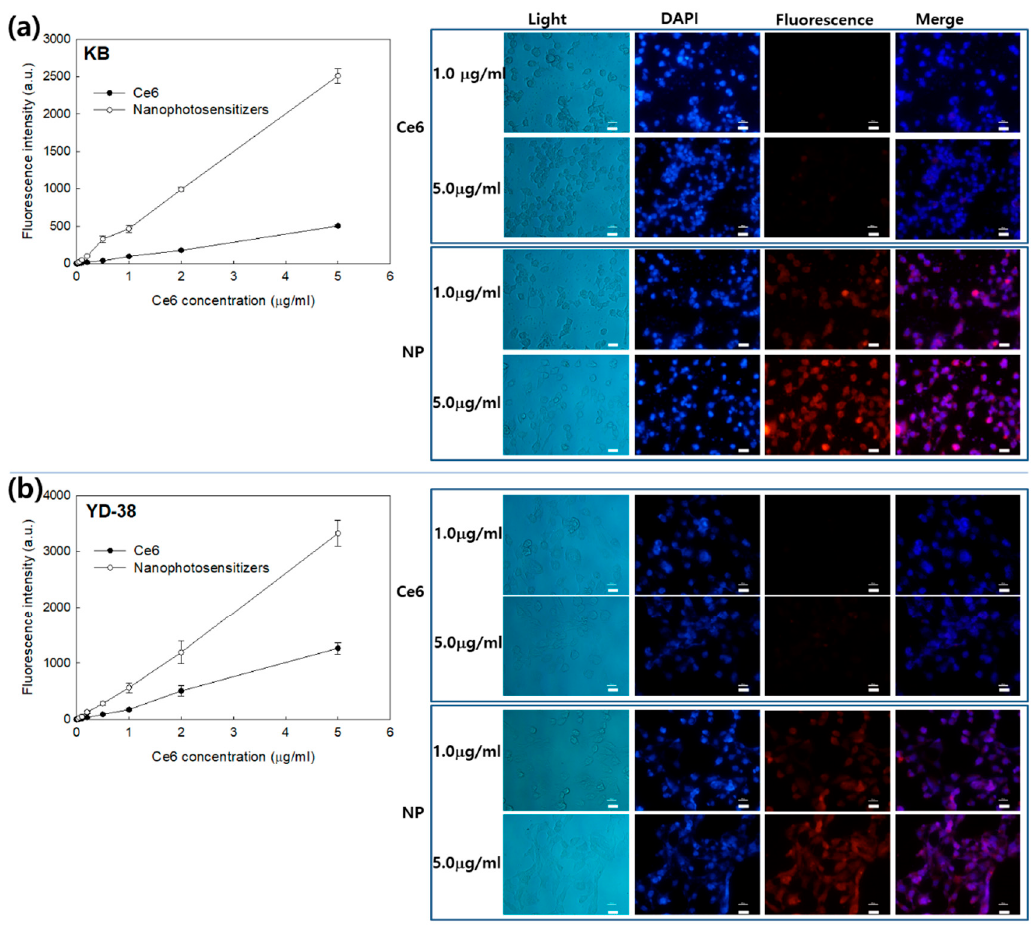
Figure 4. Ce6 uptake ratio (left panel) and fluorescence microscopic observation (right panel) of Ce6 alone and FA–PEG 3500 -ss-Ce6tri copolymer nanophotosensitizers. ( a ) KB cells; ( b ) YD-38 cells. 2 × 10 4